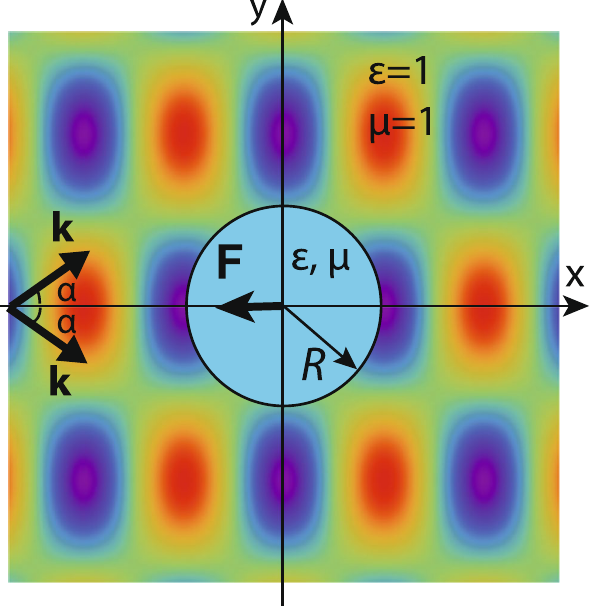
Figure 1. Continuous propagation-invariant light beam exerts pulling force F < 0 on a cylindrical object. The interference electric field pattern from a couple of TE-polarized plane waves (see equation (1)) is shown as the